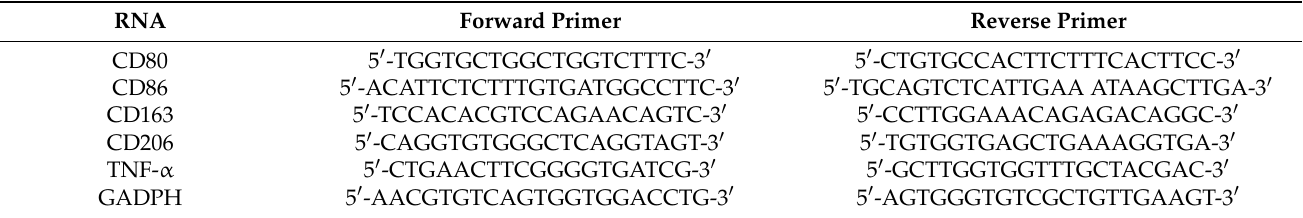
Table 1. Forward and reverse primers used for